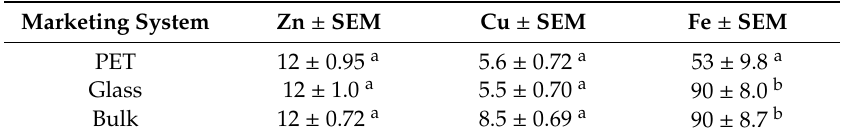
Table 2. Mean Zn, Cu, and Fe concentrations ( µ g / g) and standard error of the mean (SEM) in herbs (thyme, rosemary, cloves, oregano, and basil) according to the marketing system (in bulk, or in packaging in glass or polyethylene terephthalate